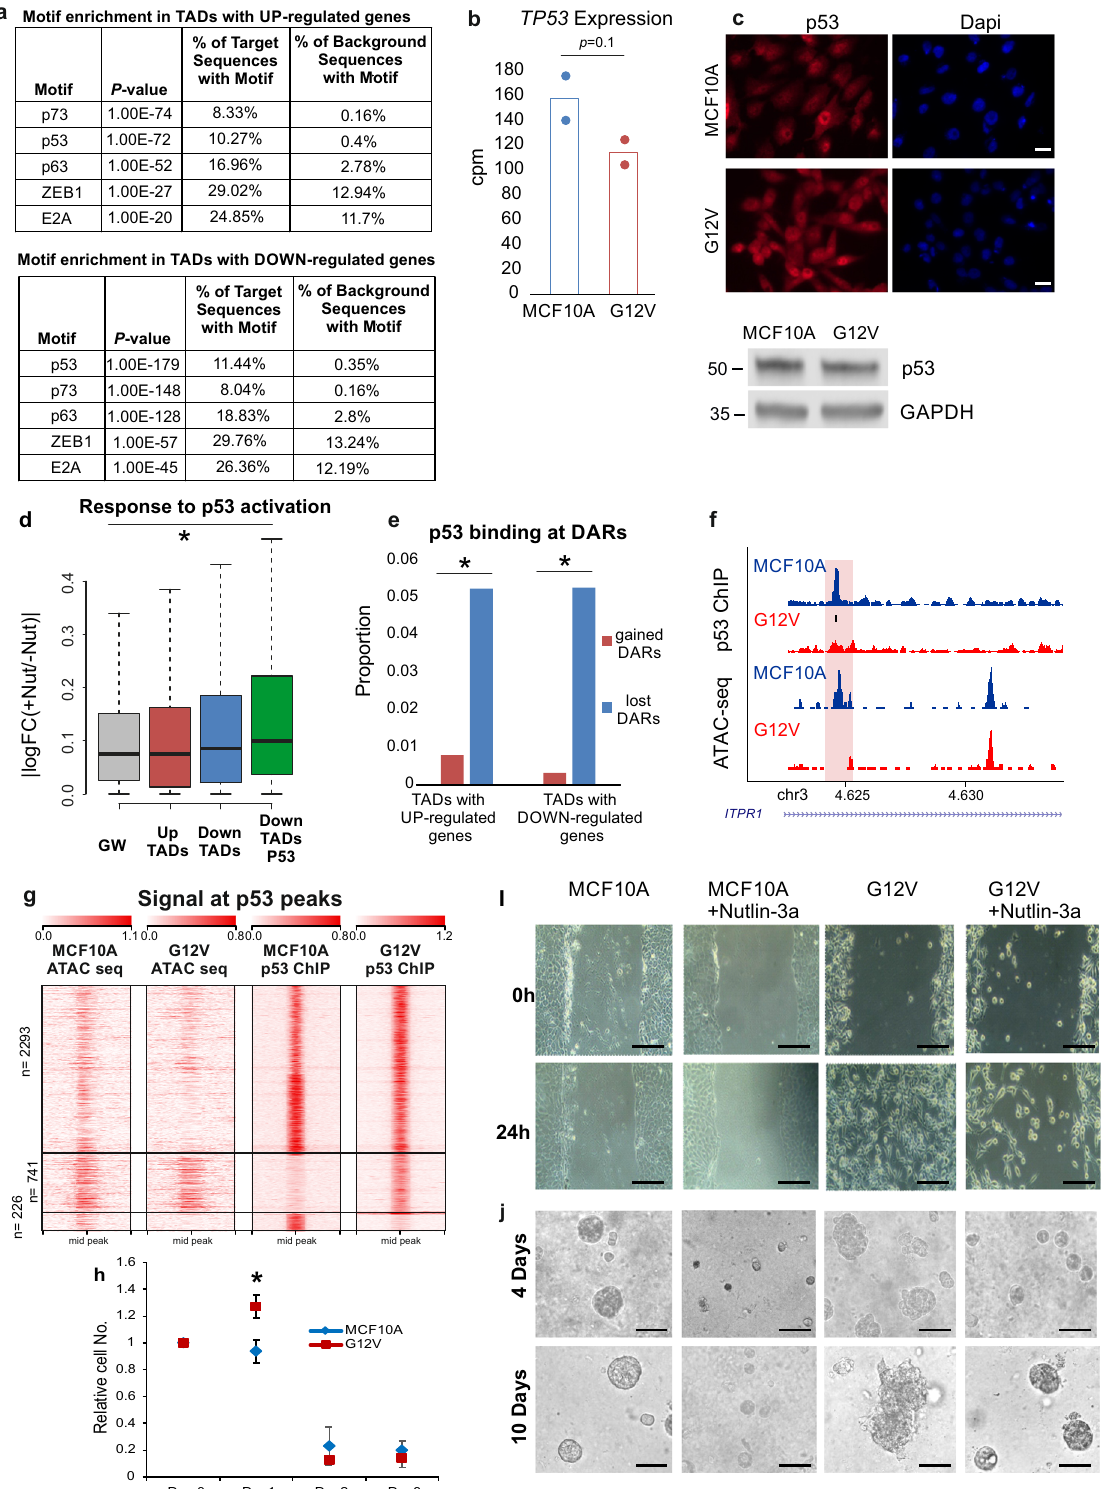
motif 54 . In addition, ATF3 and FOSL1 subunits of the AP-1 cells, were shown to have regulatory interactions with p53 55,56